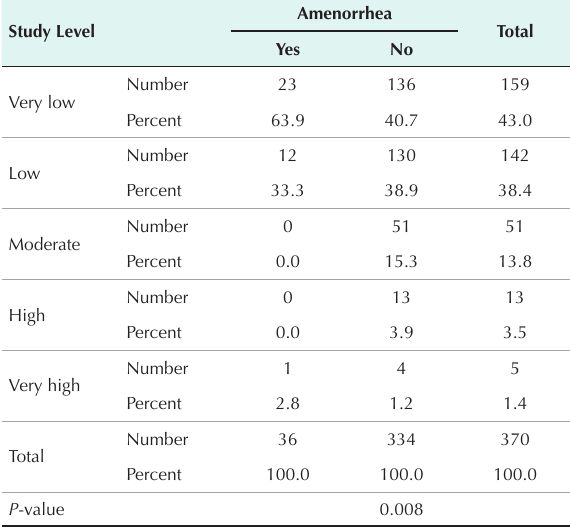
Table 4. Relationship Between Studying Books on Menstrual Disorders with the Incidence of Amenorrhea Study